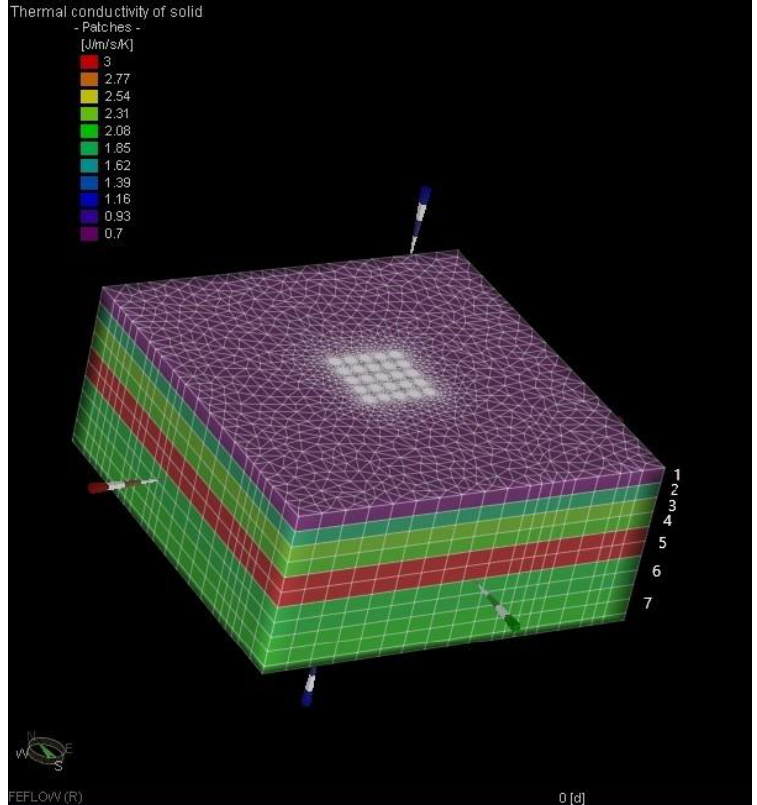
Figure 4. Thermal conductivity in the 3rd scenario model. The numbers refer to lithological layers (1: medium sands, 2: brown-gray marl, 3: brown-gray marly mudstone, 4: light gray marly mudstone, 5: sandstone, 6: beige mudstone, 7: marly claystone).